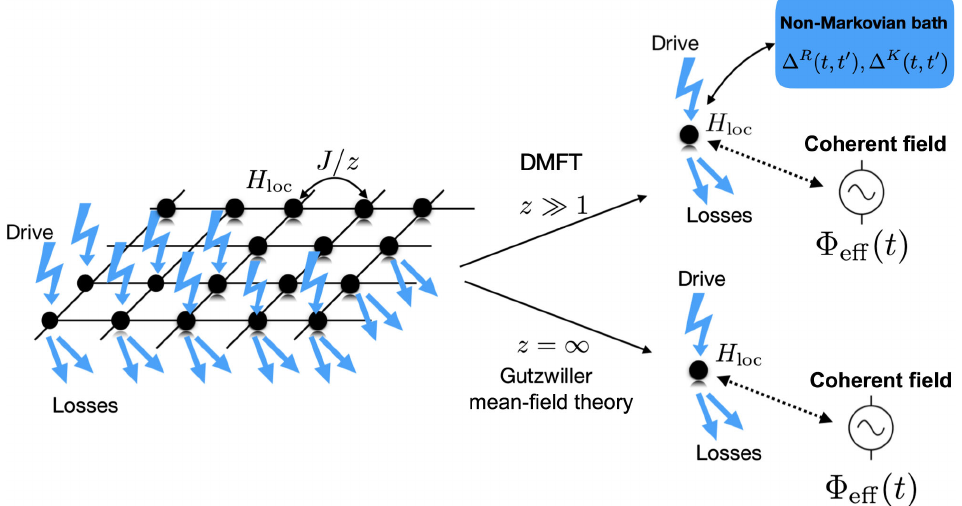
FIG. 1. Sketch of the DMFT mapping for open Markovian bosonic quantum systems. A lattice of interacting, driven-dissipative bosons coupled by hopping [left; see Eqs. (2) and (3) in the main text] is mapped in the large connectivity limit z ≫ 1 onto a single-site problem, with interactions, local Markovian drive, and losses, coupled to a self-consistent environment (right, top). This single-site problem includes a coherent drive and a non-Markovian bath [characterized by two independent hybridization functions Δ R ð t; t 0 Þ and Δ K ð t; t 0 Þ ] which accounts for fluctuations due to neighboring sites. In the infinite coordination limit z ¼ ∞ , one recovers the Gutzwiller mean-field theory (right, bottom), where the effect of the lattice is simply encoded in a self-consistent